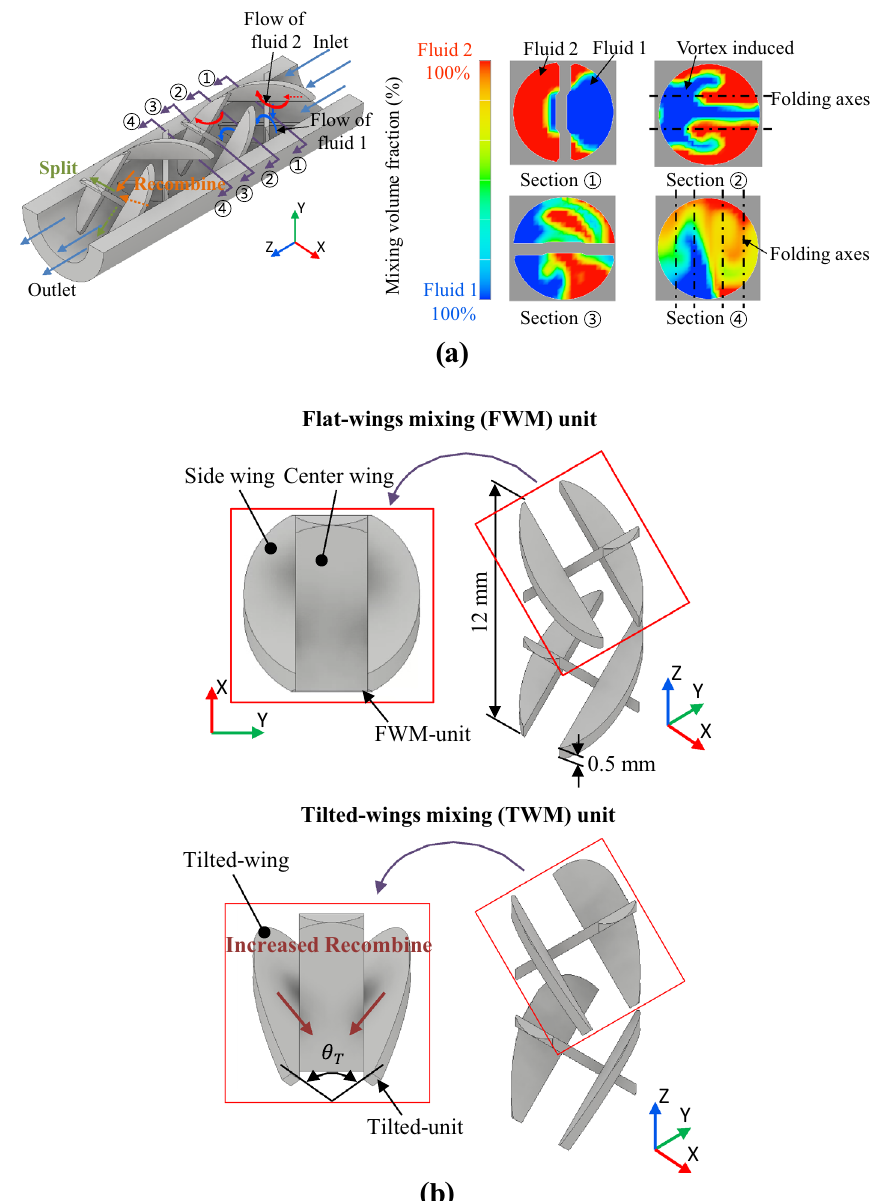
Figure 2. Mixing mechanism and shape of mixing unit. ( a ) Mixing mechanism for FWM unit and cross- section; the color contour of the section shows a mixing volume fraction. Baker’s folding process (split and recombination) is performed due to the turbulence caused by wings of mixing unit, and ( b ) cocrison of mixing performance of FWM unit and tilted wing unit (TWM unit), which has θ T (degree between tilted-wings) for increasing recombination function to enhance mixing